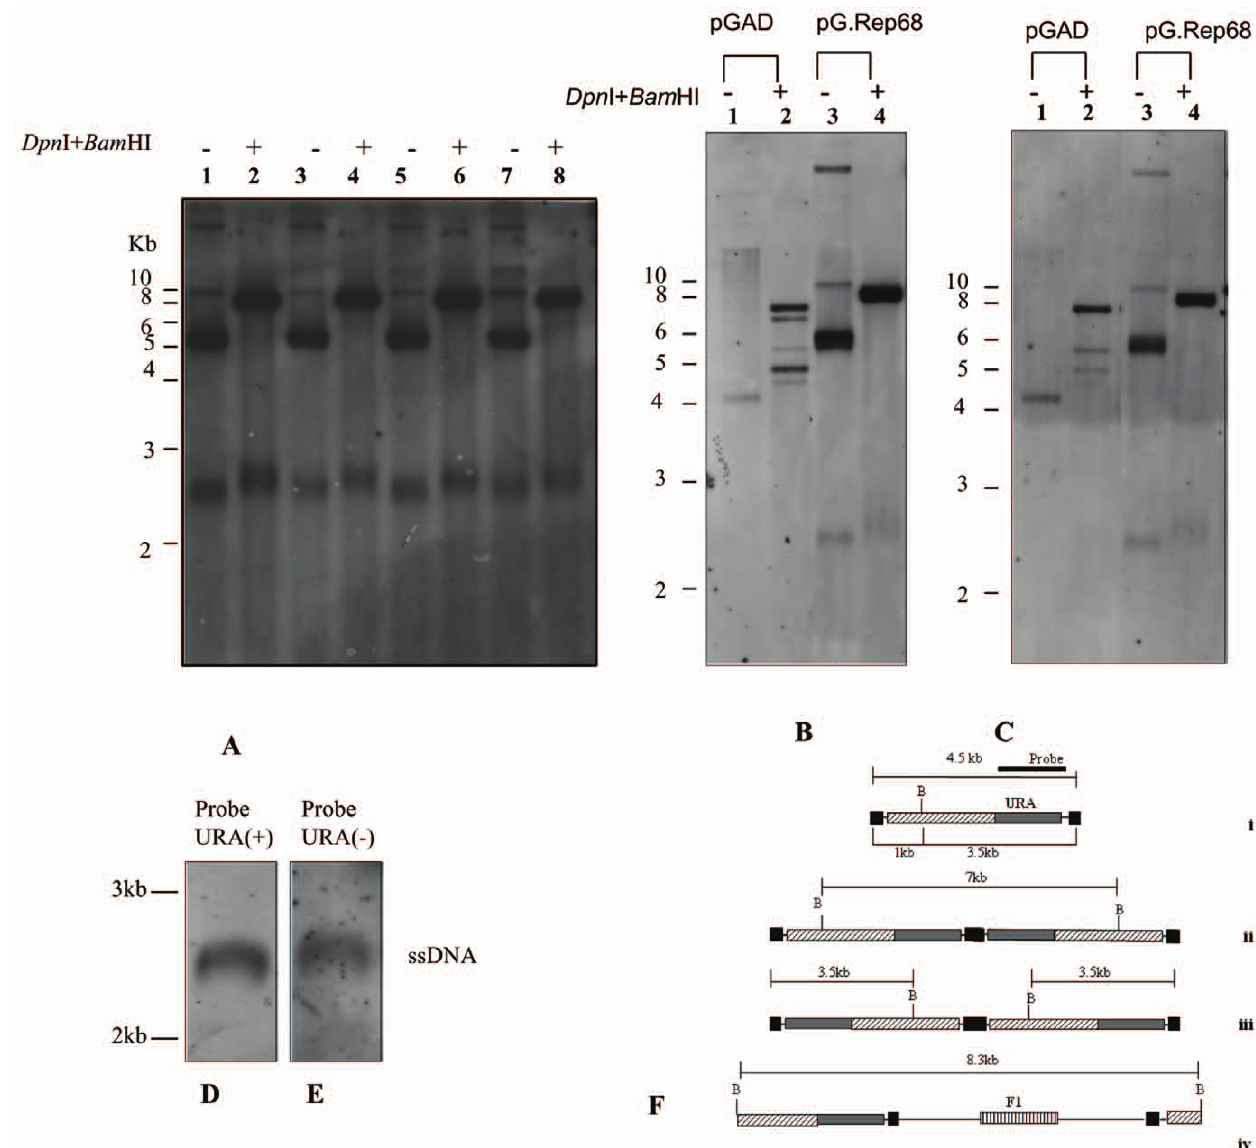
Figure 6. Characterization of newly replicated DNA. (A) Low M r DNA of four clones derived from yeast co-transformed with pAAVRepURA and pG.Rep68 digested with Dpn I and Bam HI (lane 2, 4, 6, 8) and not digested (lane 1, 3, 5, 7) was analyzed on Southern Blot and probe with the URA3 gene. Bam HI cuts once in AAV construct. (B, C) Low M r DNA of one clone obtained from the co-transformation of pAAVRepURA with pGAD not digested (lane 1) and digested with Dpn I and Bam HI (lane 2); the low M r DNA of one out four clones analyzed in panel A undigested (lane 3) and digested with Dpn I and Bam HI (lane 4) was analyzed on Southern Blot and detected with URA3 probe (B) and F1 probe (C). (D, E) Equal amount of low M r DNA of one out of four clones analyzed in panel A was loaded in two gel slots and transferred on nylon membrane. The membrane was cut in two pieces corresponding to gel slots and further cut to leave only ssDNA. The ssDNA was detected using as probe a 100-mer oligonucleotide complementary to the filament ( + ) of the URA gene URA( + ) (D), or a oligonucleotide probe complementary to filament (-) of the URA gene URA(-) (E), to determine the polarity of ssDNA. (F) Restriction maps of predicted replicative intermediates: i) linear monomer, ii) tail-to-tail dimer, iii) head-to- head dimer, iv) linear vector. Position of Bam HI is indicated with B. The sizes of the fragments liberated following Bam HI cleavage and recognized by the URA probe are shown next to corresponding structures. ITRs are indicated as black boxes. doi:10.1371/journal.pone.0023474.g006 rather we found only one band of , 8 kb (lanes 2, 4, 6, 8) which is DNA with Bam HI that cuts pAAVRepURA only once in rep the size of the linearized plasmid containing the backbone and sequence at 1 kb (Fig 6F, i). If the newly replicated molecules AAV genome (Fig 6F,iv). would be generated according to AAV replication model observed To confirm this hypothesis, we digested with Bam HI the low M r in human cells, the Bam HI digestion of low M r DNA detected with URA3 probe, would produce a band of 3.5 kb in case of linear DNA isolated from a URA3 + LEU2 + clone carrying pAAVRe- monomer (Fig.6F,i); a band of 7 kb in case of tail to tail dimer pURA plus pGAD (Fig. 6B, lane 2; fig. 6C,lane 2) or pAAVRe- (Fig.6F,ii); a band of 3.5 kb in case of head to head (Fig.6F,iii). As pURA plus pG.Rep68 (Fig.6B, lane 4; fig.6C,lane 4) and hybridised shown in Fig.6A, no one of this molecules was produced, but with the F1 (Fig.6B) that recognizes F1 origin of replication that is